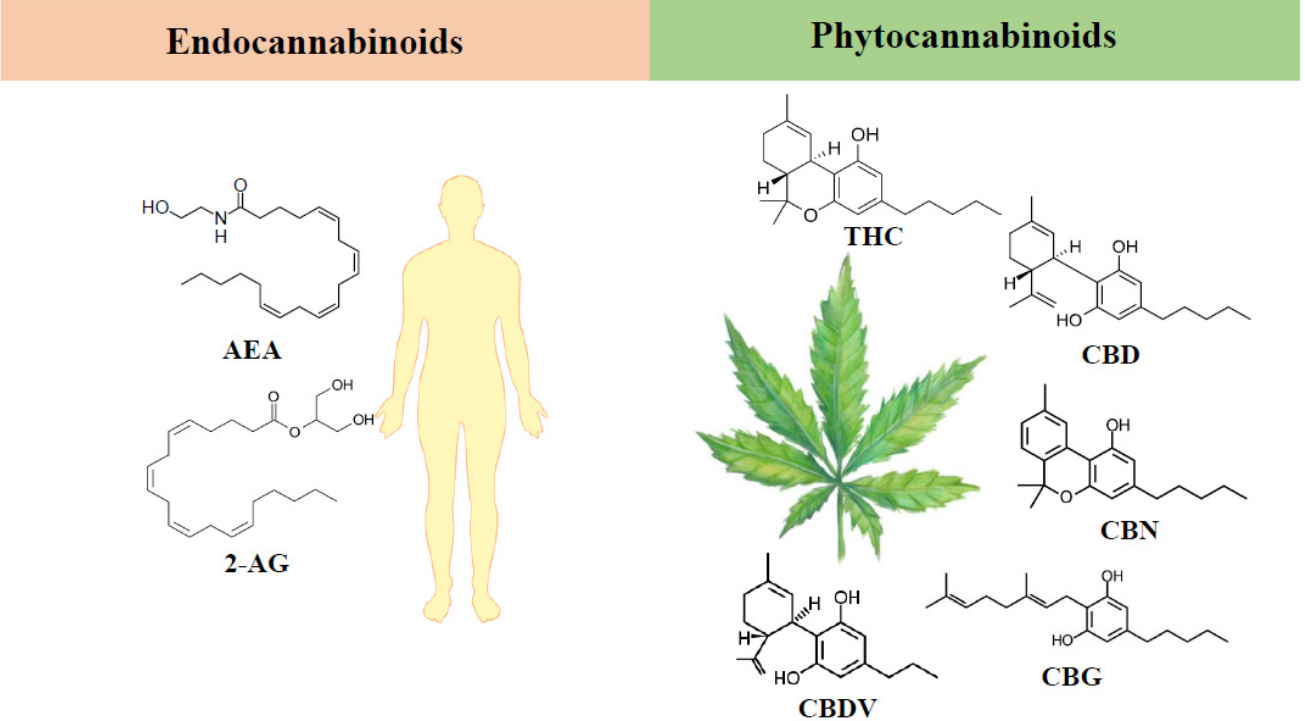
Figure 1. Chemical structures of the major endocannabinoids and phytocannabinoids. The endocannabinoids depicted are anandamide (AEA) and 2-arachidonoylglycerol (2-AG), and the phytocannabinoids are Δ 9 -tetrahydrocannabinol (THC), cannabidiol (CBD), cannabinol (CBN), cannabigerol (CBG) and cannabidivarin (CBDV).